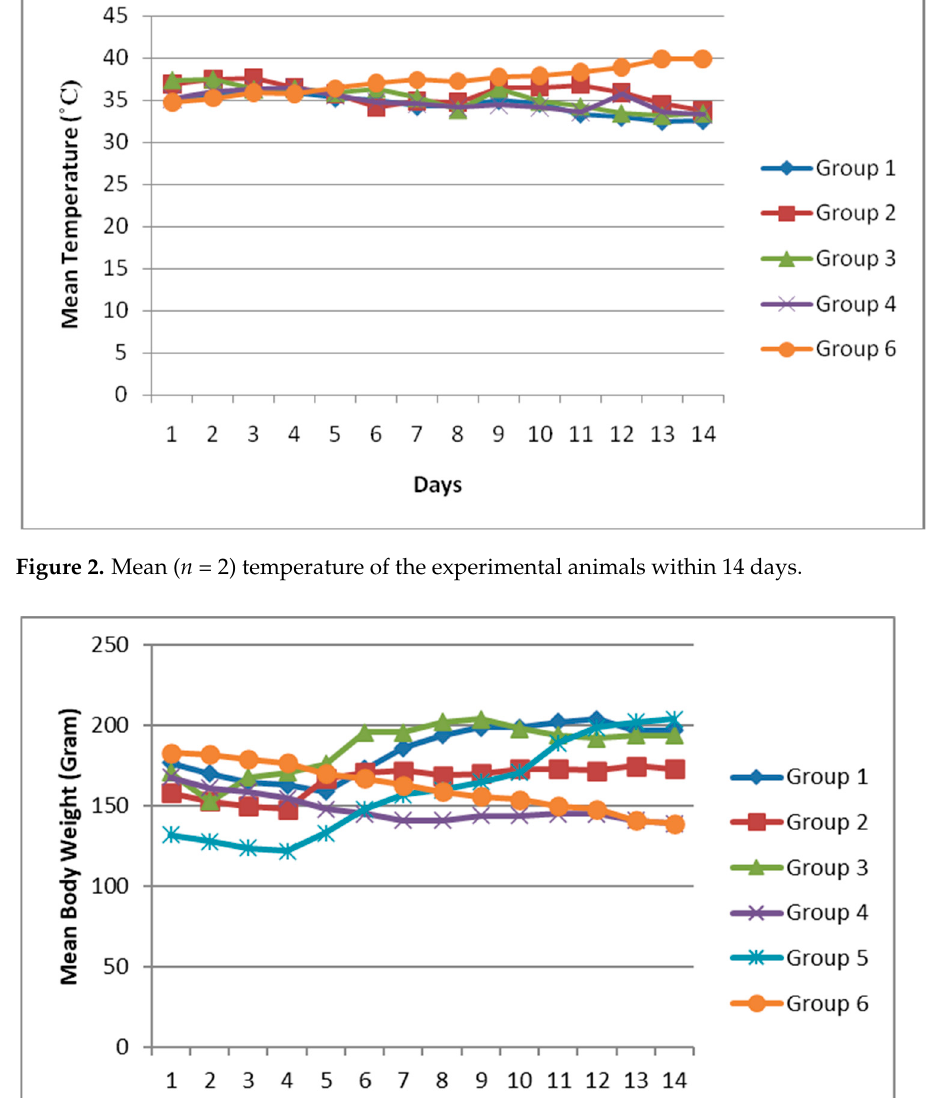
Figure 2. Mean ( n = 2) temperature of the experimental animals within 14 days.